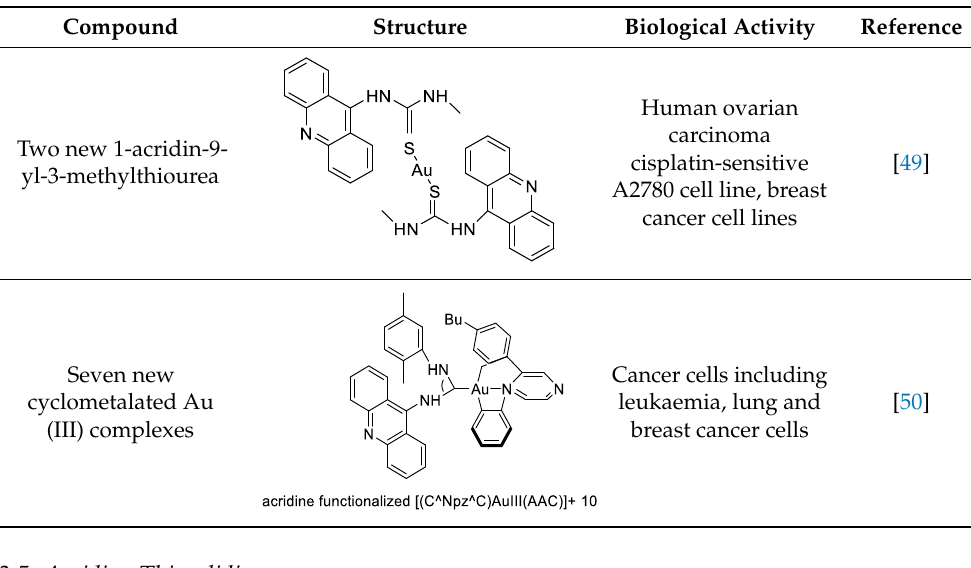
Table 4. Acridine Thiourea gold as an anti-tumour agent.